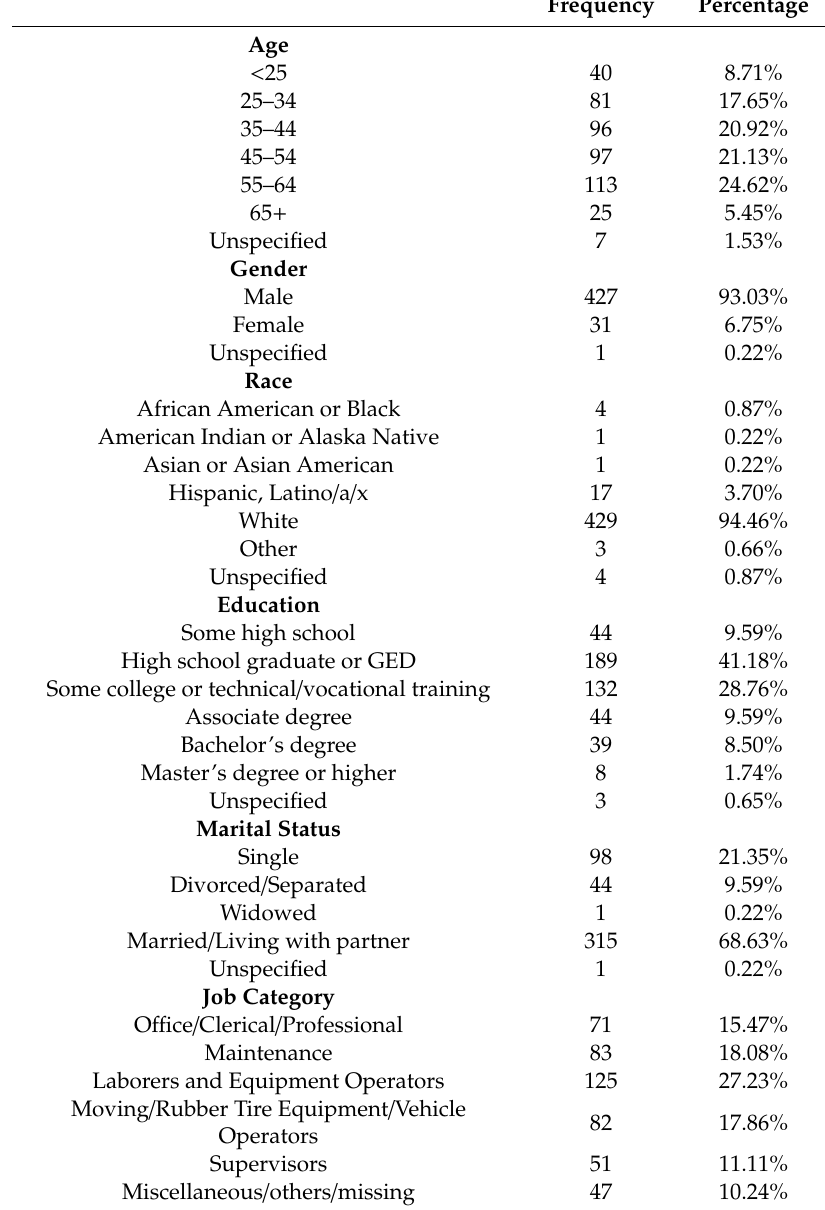
Table 1. Summary of Study